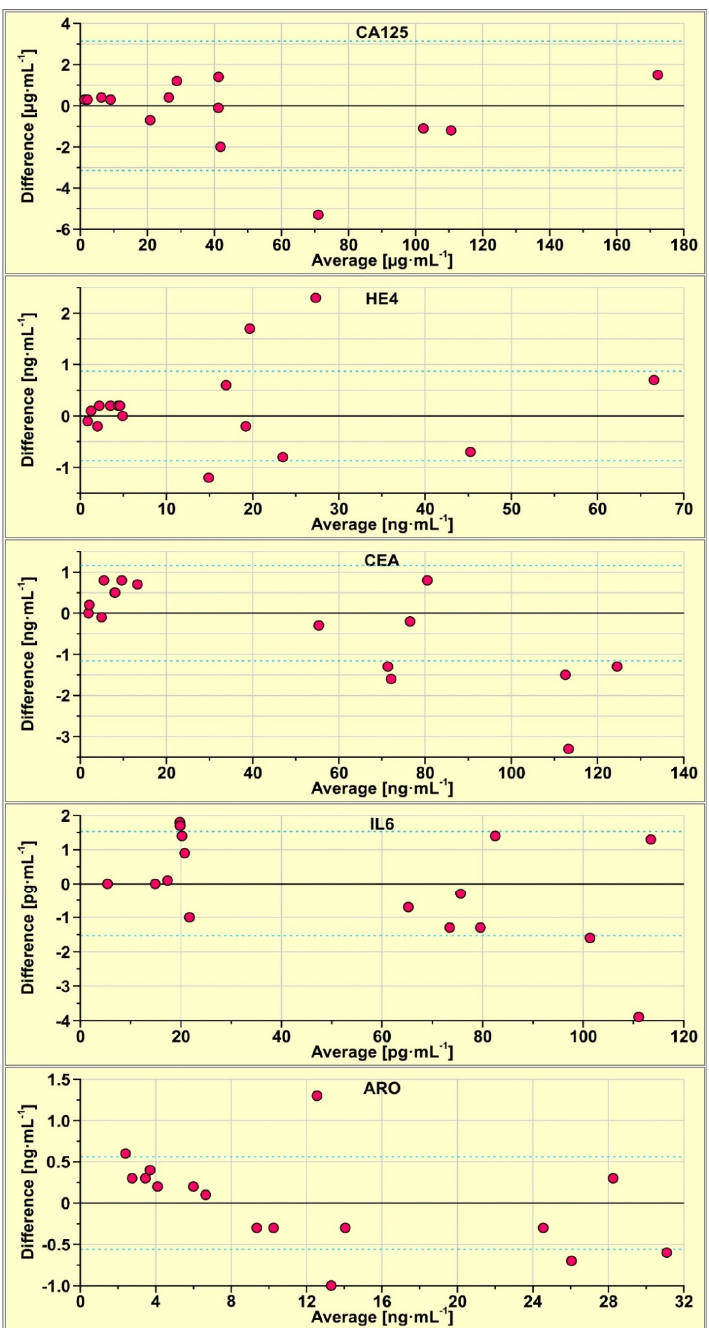
Figure 2. Bland-Altman plots of the results obtained with the multiple biosensor and those obtained with single